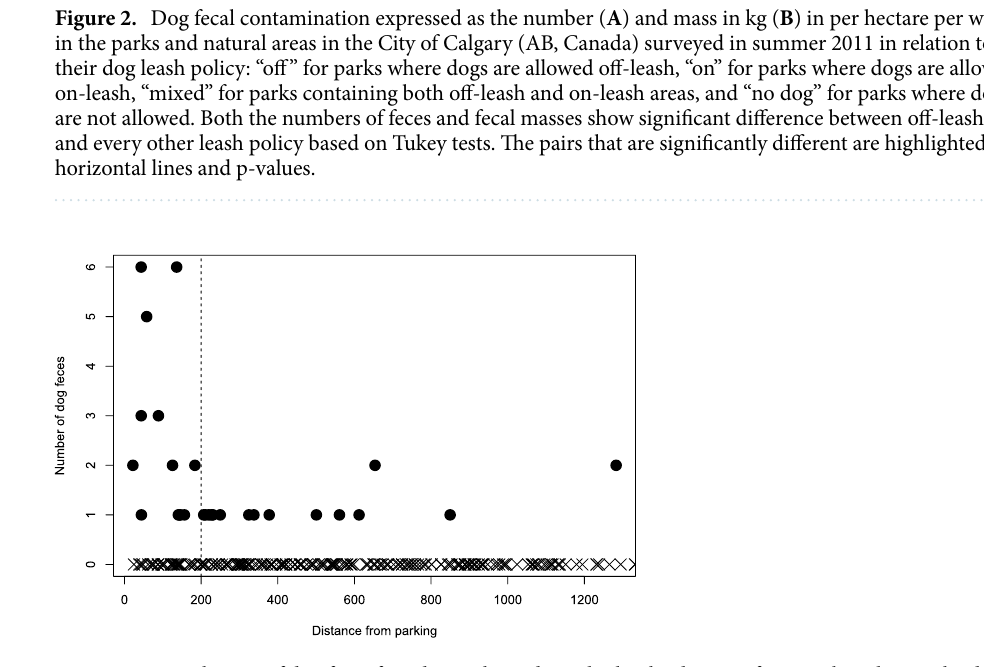
Figure 3. Distribution of dog feces found at each random plot by the distance from parking lots in the dog fecal contamination surveys carried out in 2011 in the city of Calgary (AB, Canada). Black dots indicate plots where some dog feces were found, X symbols indicate plot with no dog feces found. Dashed line indicates the threshold of 200 m from the nearest parking